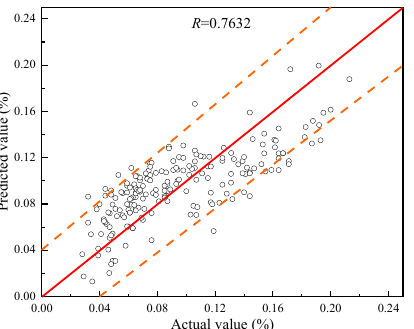
Figure 5. Comparison of predicted and actual values of end-point carbon content for ANN.